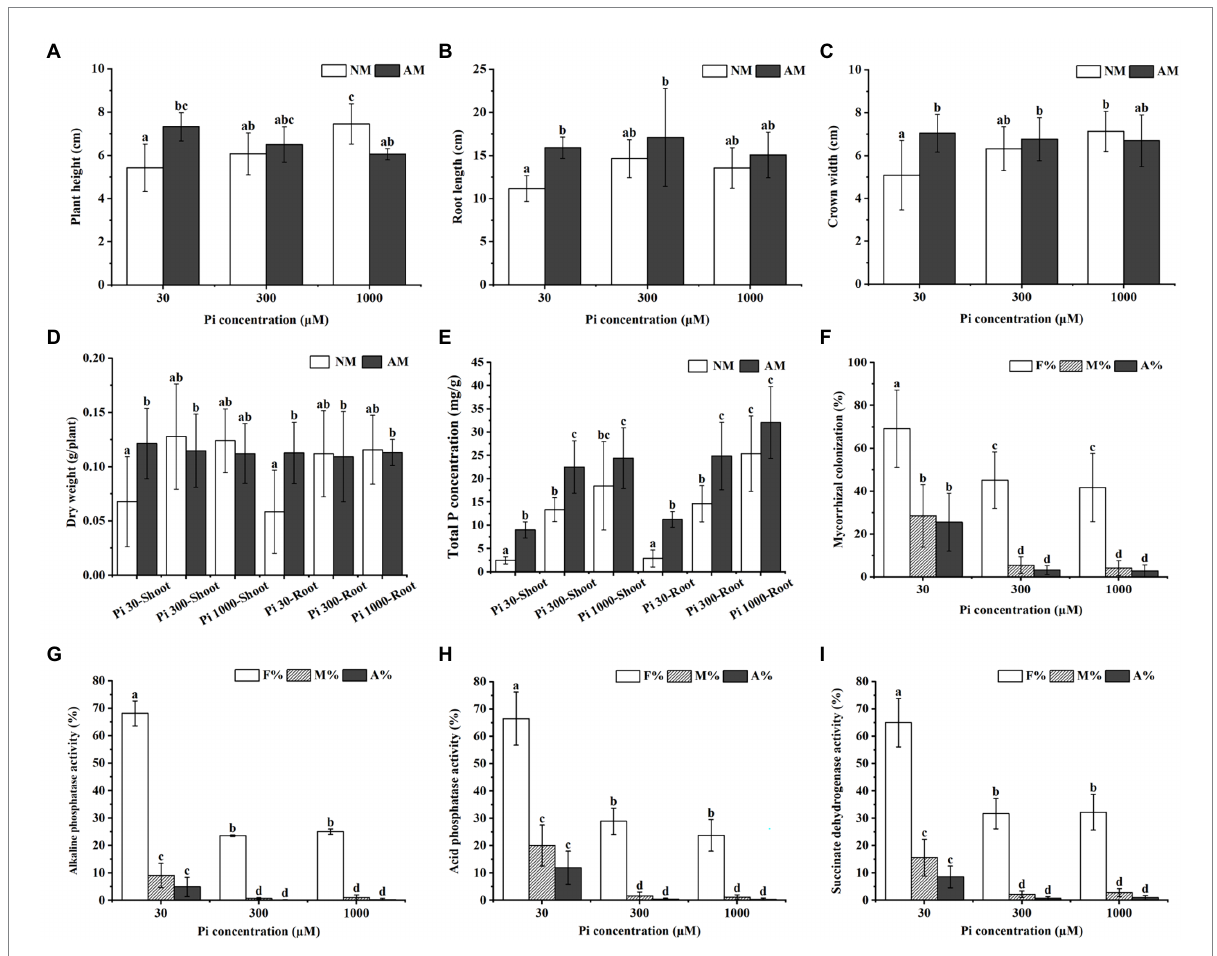
FIGURE 1 Impact of different Pi concentrations and AMF colonization on Eucalyptus grandis growth and enzyme activities within mycorrhizal roots. (A–D) The growth performances of NM and AM E. grandis plants under different phosphate concentrations. (E) Total P concentrations of shoots and roots of NM and AM E. grandis with R. irregularis grown at different Pi levels. (F) Mycorrhizal colonization levels among different phosphate concentrations were determined in roots after the WGA488 staining. (G–J) Impact of phosphate concentrations on three enzymes activities, including alkaline phosphatase (ALP), acid phosphatase (ACP) and succinate dehydrogenase (SDH), which are involved in AM fungal metabolism and Pi homeostasis during symbiosis. Data on the pictures are obtained by the ALP (G) , ACP (H) , and SDH (I) activities staining, respectively. (F–I) F%, the total colonization frequency; M%, the percentage of mycorrhizal intensity; A%, the percentage of arbuscule abundance. Error bars represent the mean of five biological replicates ± SD. Averages with the different letters on the top of the column mean significantly differences at p < 0.05 level, based on Duncan’s new multiple range